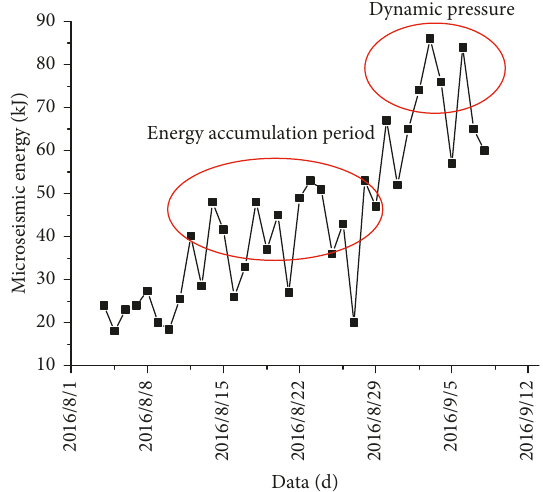
Figure 6: Microseismic energy distribution.